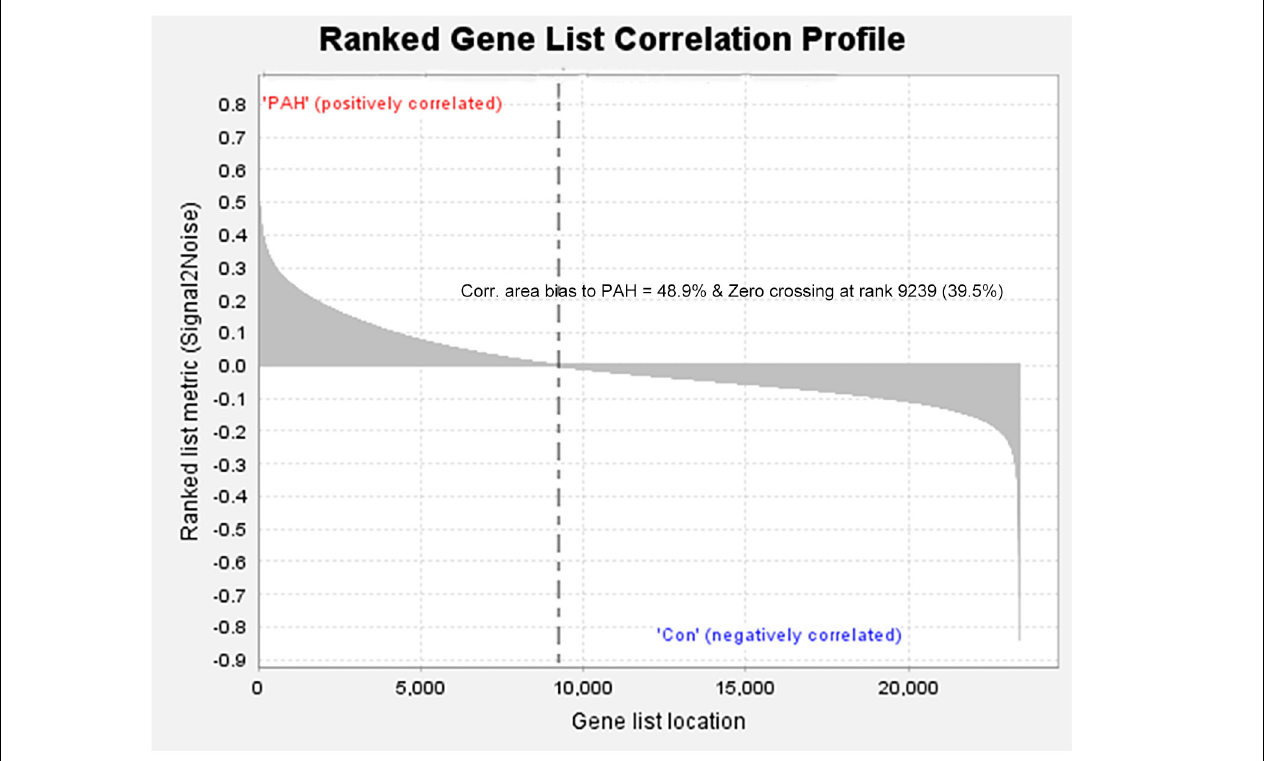
FIGURE 2 | All genes were distributed according to the signal-to-noise ratio (SNR). Based on its SNR, the distribution of 23,410 genes in the two groups was mapped.